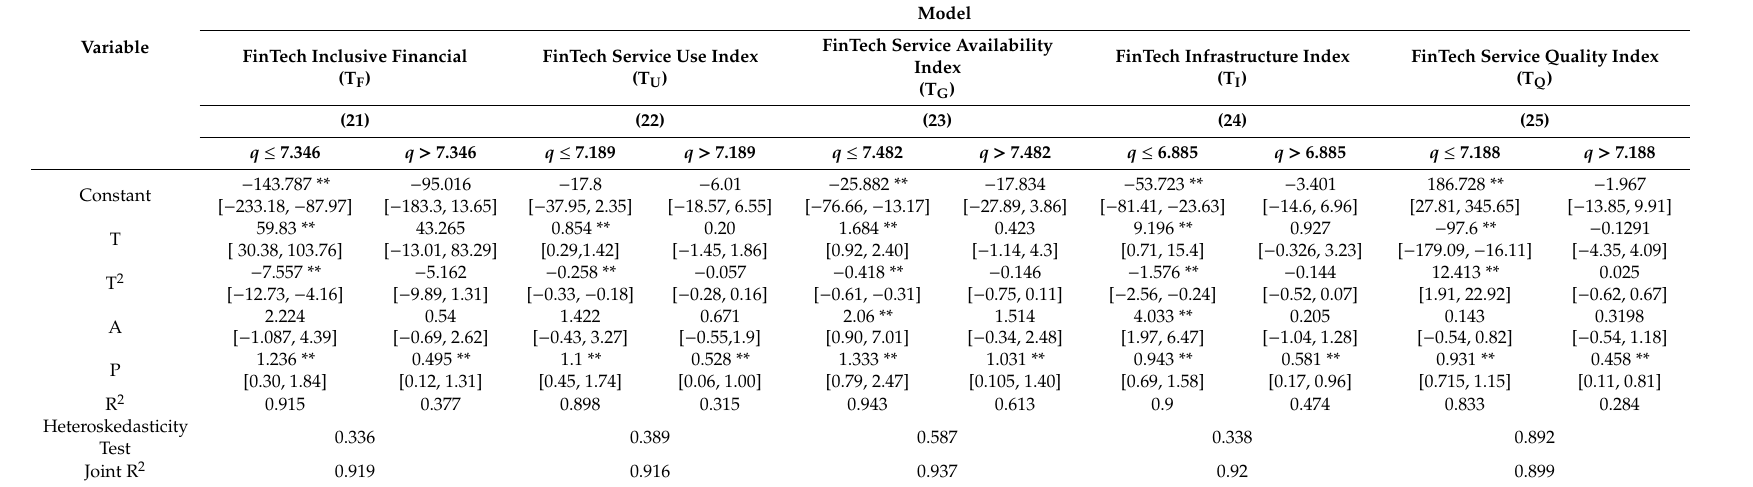
Table 6. Estimation results of the threshold model for the impact of FinTech on agricultural NPS